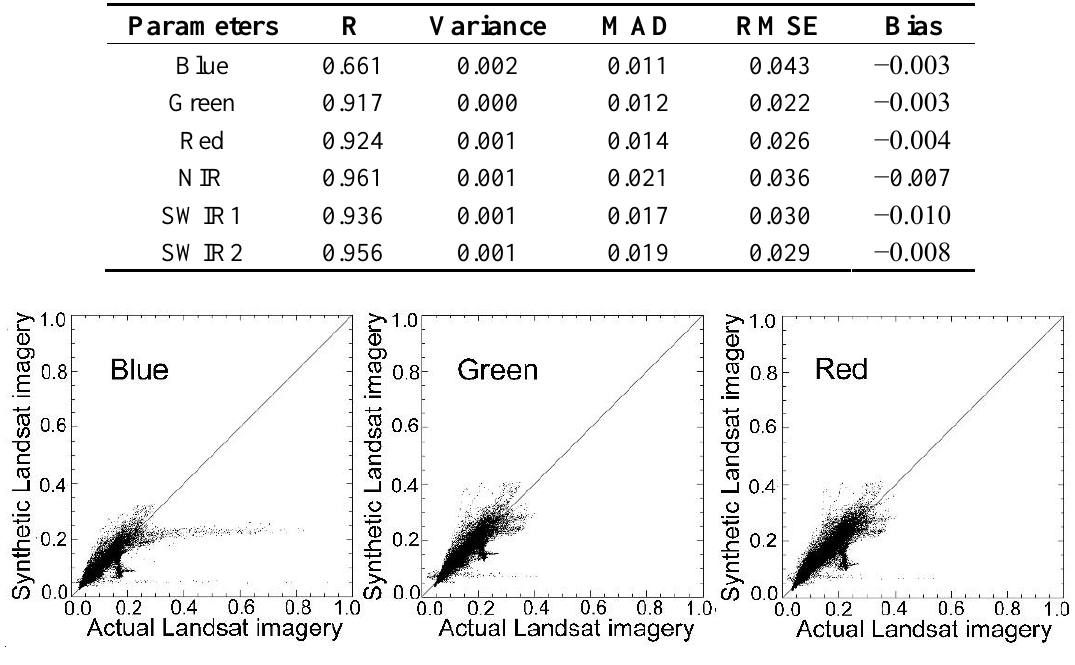
Table 8. Results of correlation analysis between synthetic and actual Landsat imageries using the modified spatial and temporal data fusion approach (MSTDFA) with input of Finer Resolution Observation and Monitoring of Global Land Cover (FROM–GLC)